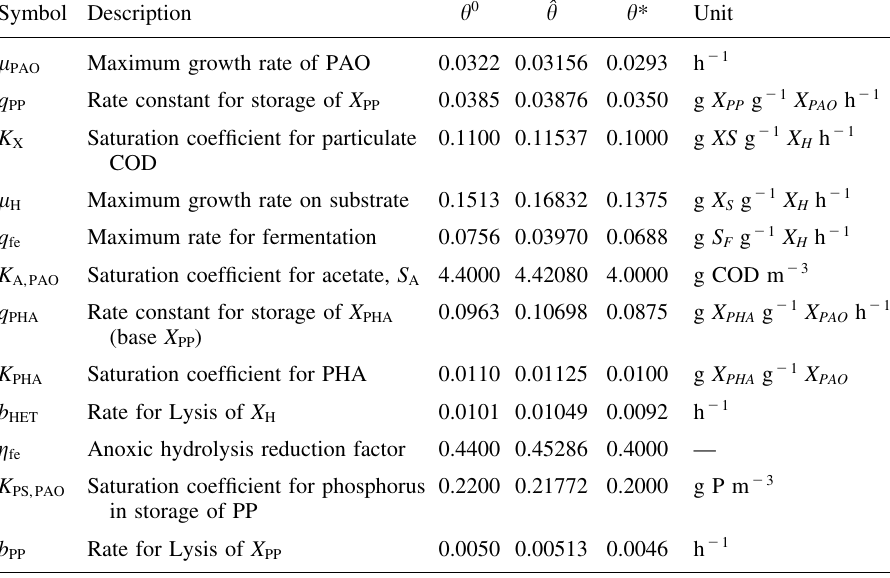
Table 5. Comparison of initial and estimated parameter